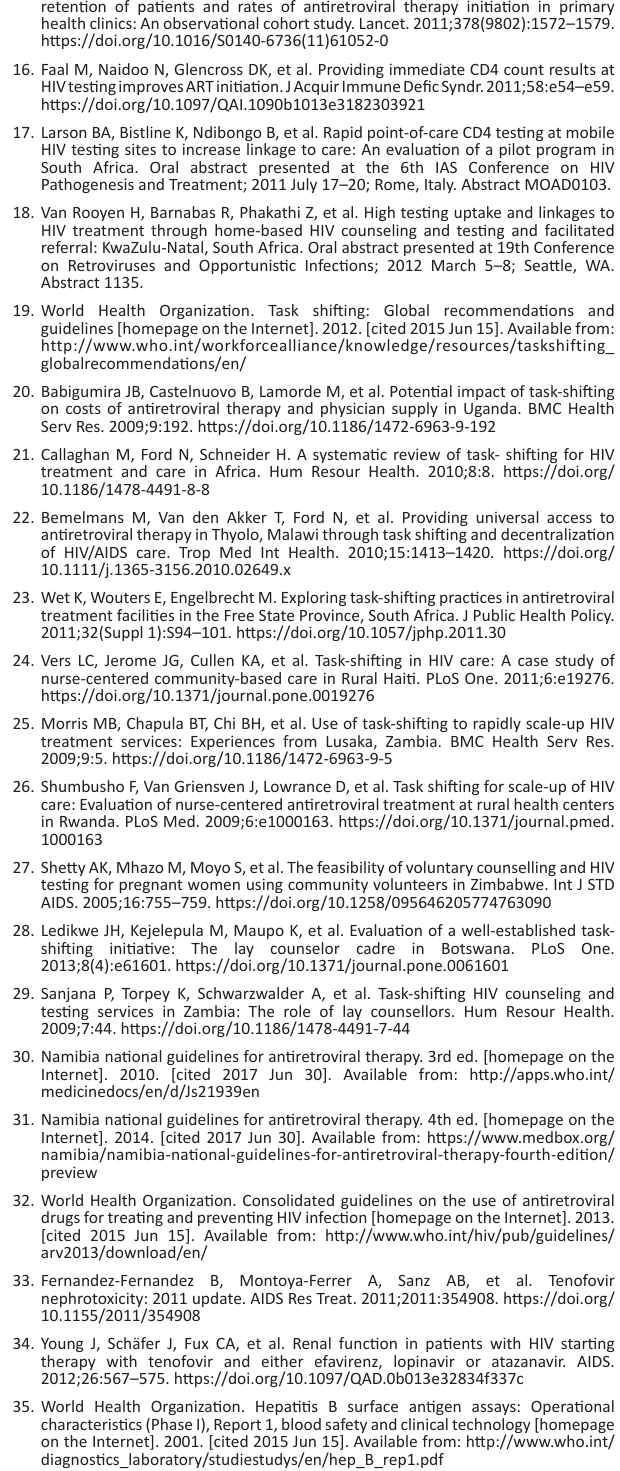
referral: KwaZulu-Natal, South Africa. Oral abstract presented at 19th Conference on Retroviruses and Opportunistic Infections; 2012 March 5–8; Seattle, WA. Abstract